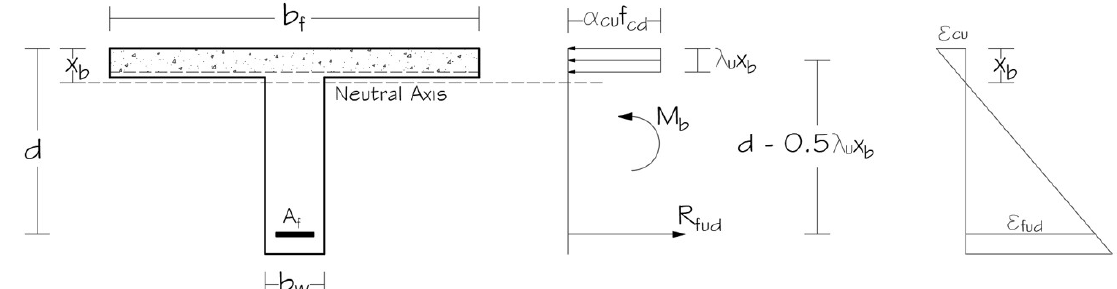
Figure 2. Equilibrium and compatibility of a balanced cross-section with the simplified stress block located on the flange [8]